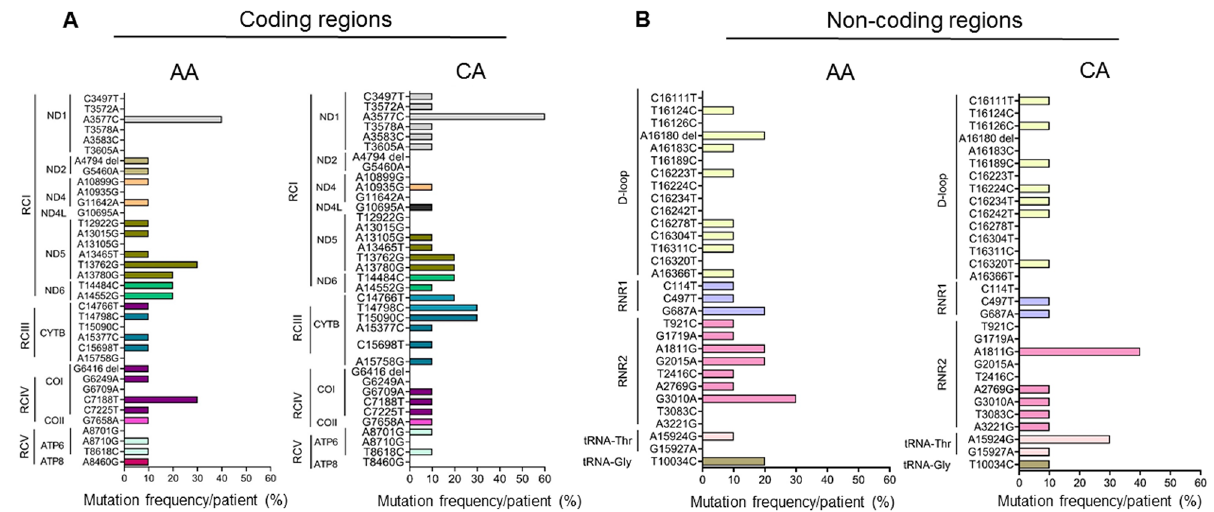
Figure 5. Racial differences in type and frequency of mtDNA mutations. Nature and pattern of mtDNA mutations in the coding ( A ) and non-coding ( B ) regions of the mtDNA among the African American (AA) and Caucasian American (CA) subjects. Different mutations from each gene are represented by a single color. RC: Respiratory complex. ND : NADH Dehydrogenase; CYTB : Cytochrome B; CO : Cytochrome C Oxidase; ATP6